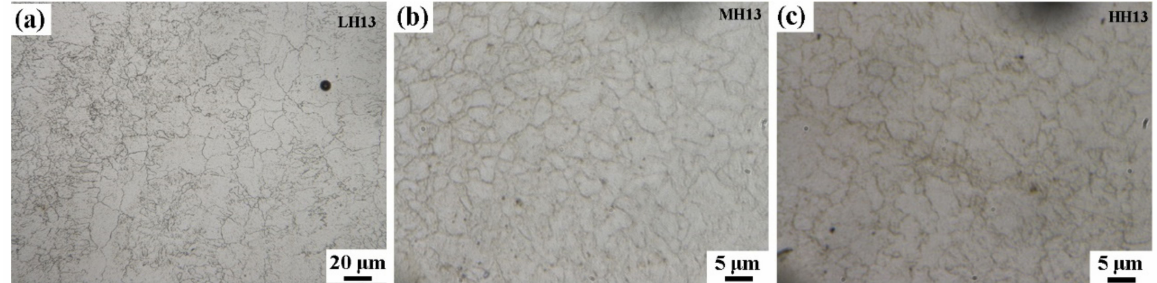
Figure 10. Grain maps given by the optical microscope of ( a ) LH, ( b ) MH, and ( c ) HH after thermal fatigue